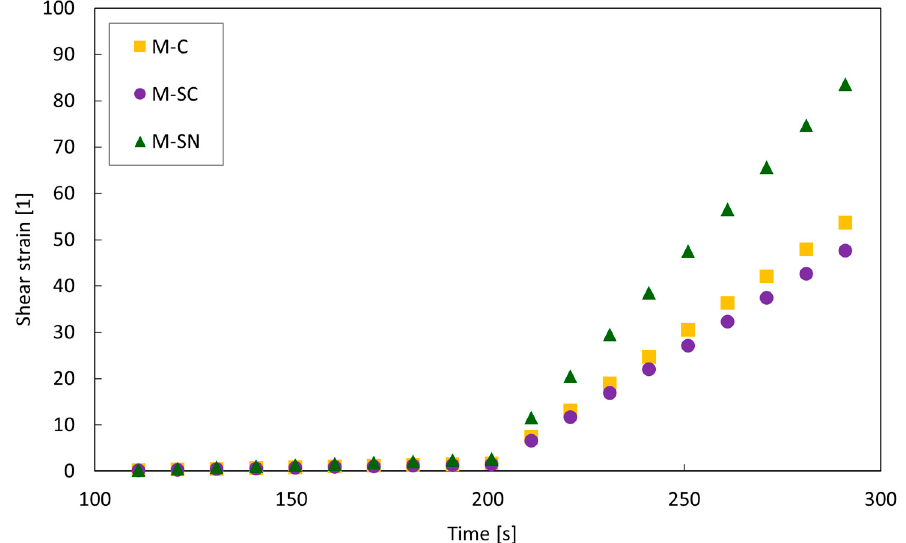
Figure 3. The results of the MSCR tests at 60 °C for all mastic samples.